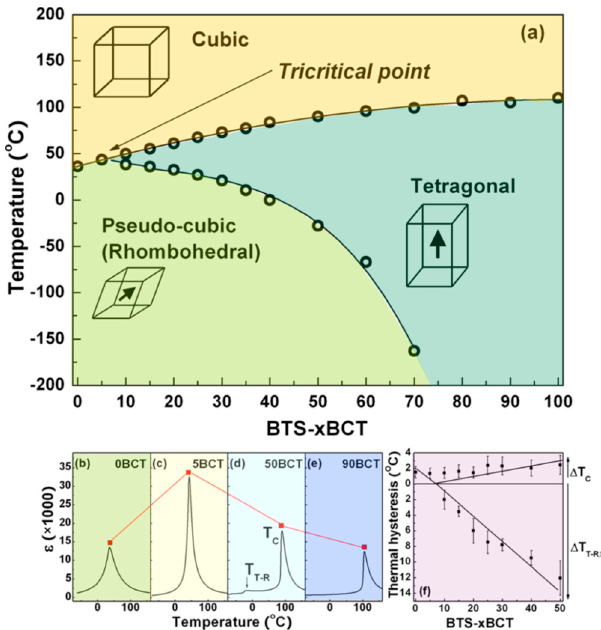
Figure 15. ( a ) Phase diagram for the BST–BCT material system. ( b – e ) Dielectric permttivity for 0BCT, 5BCT, 90BCT. ( f ) Change of thermal hysteresis with composition [15].